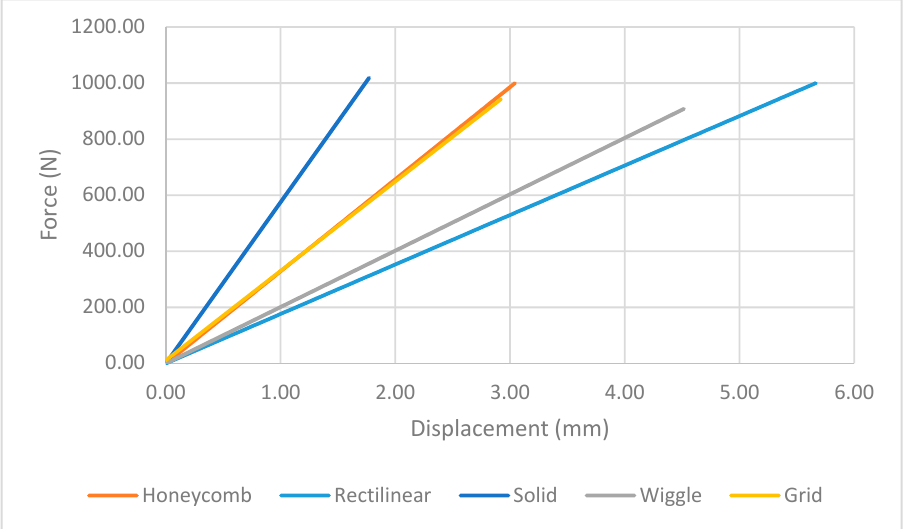
Figure 8. Force-displacement line chart for patterns.